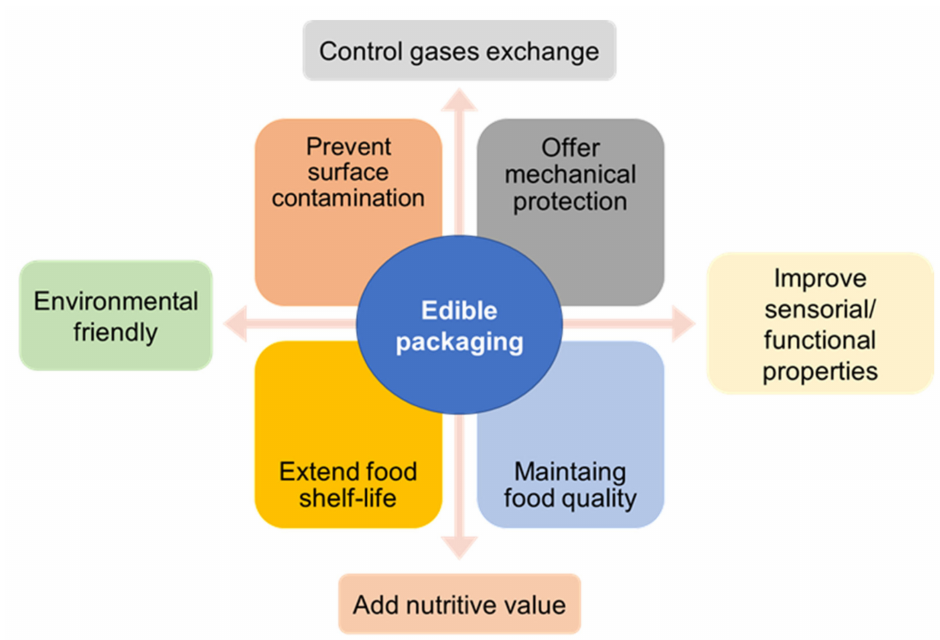
Figure 6. Main purposes of an edible food